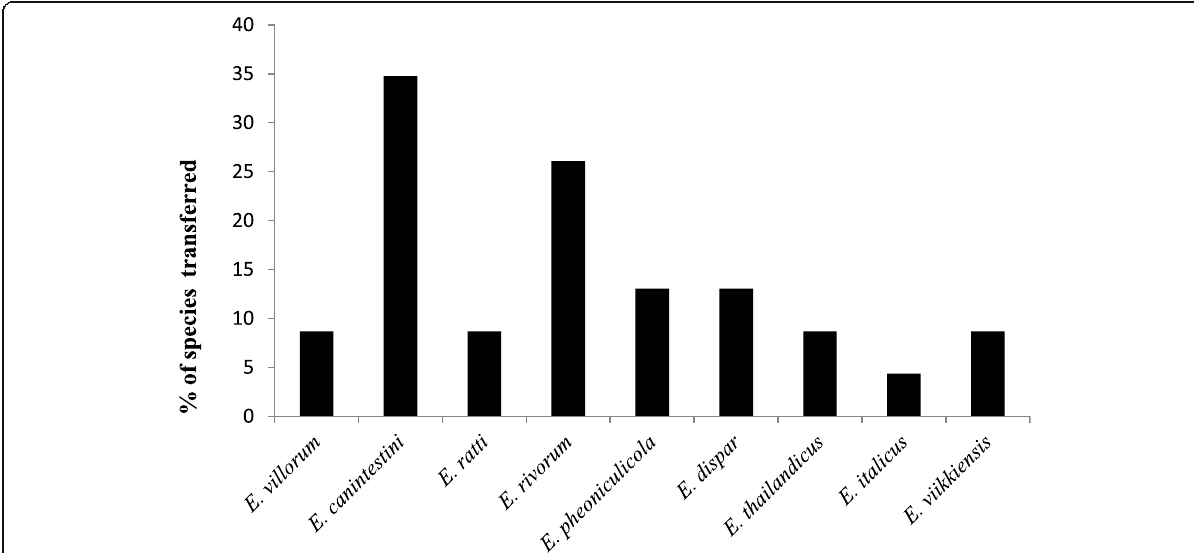
Fig. 2 Percentage distribution of Enterococcus species transferred to the infant during vaginal